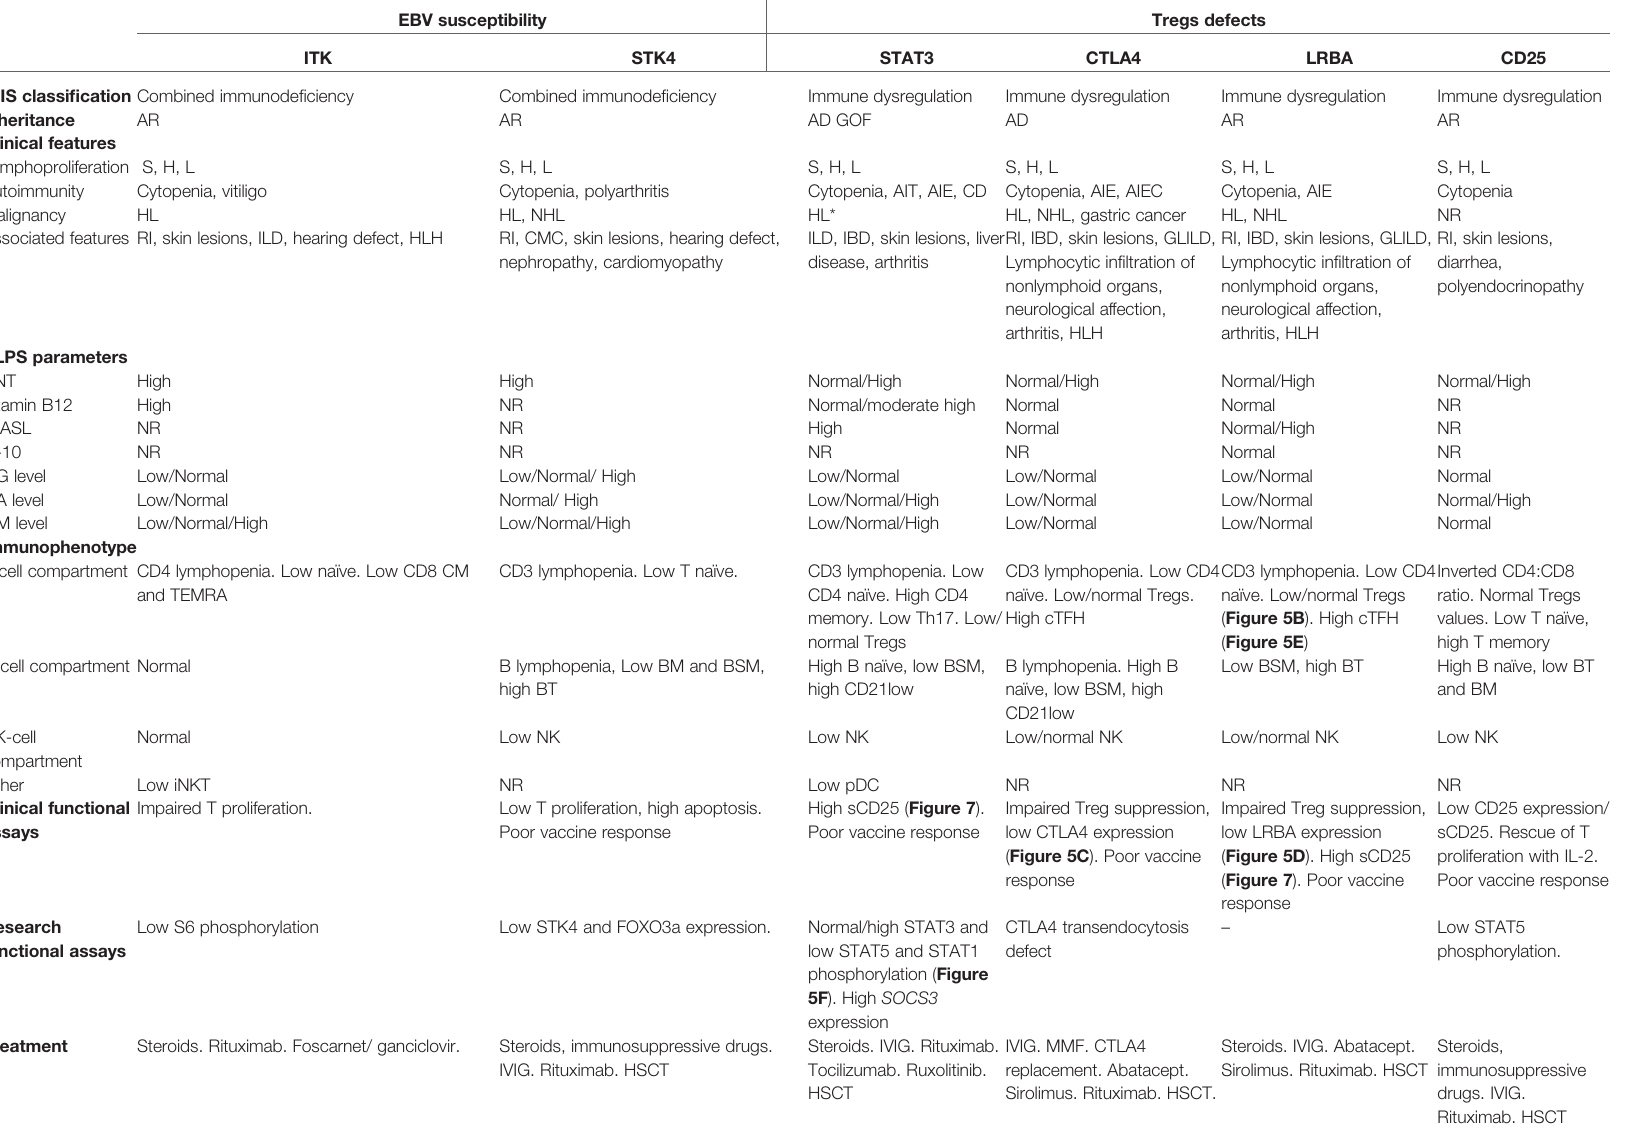
IVIG. MMF. CTLA4 replacement.